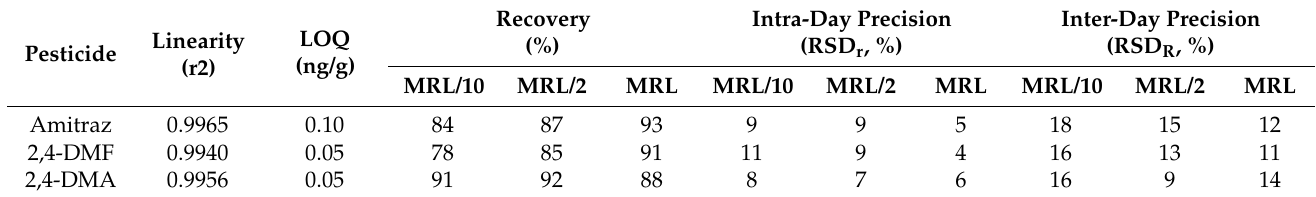
Figure 2. Time dependence of ROS-induced fluorescence in HepG2 cells for ( a ) amitraz, ( b ) 2,4-DMF and ( c ) 2,4-DMA. Fluorescence of the oxidized diclhorofluoresceine was followed by emission and excitation wavelengths at 535 and 485 nm, respectively. Results are expressed as mean ± SEM ( n = 3). (*) p ≤ 0.05 indicates significant differences from control. Table 2. The validation parameters of the optimized method for amitraz, 2-4-DMA and 2,4-DMF in